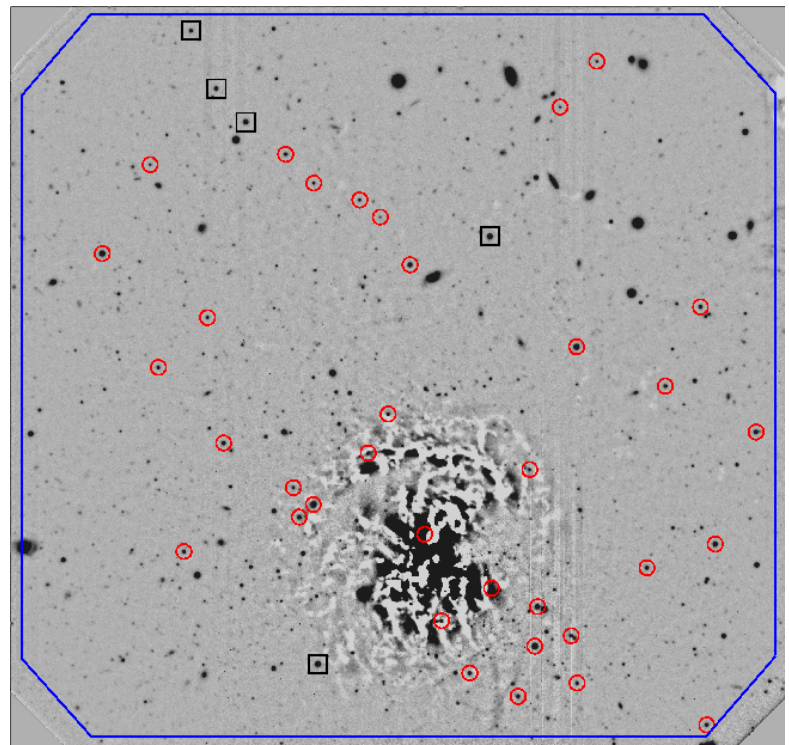
Figure 1. Image used as pre-image for spectroscopy in which the halo of NGC1316 has been subtracted. Confirmed GCs are shown with red circles and field stars with black squares (see Section 3). The North is up and East to the left. The field of view (FOV) is 5.5’ ×